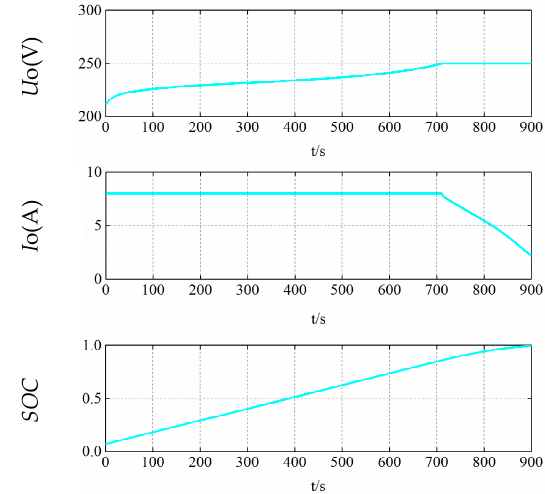
Figure 9. Charging characteristic curve of battery under primary side control.